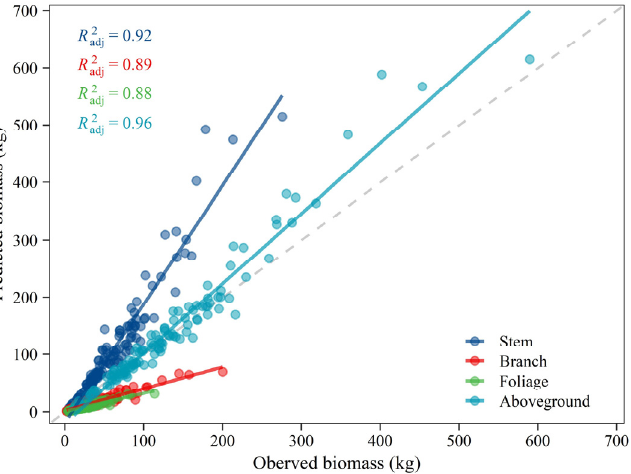
Figure 7. Relationships between measured biomass of each component and total aboveground biomass in this study for comparison with published equations of Dong, et al. [28].